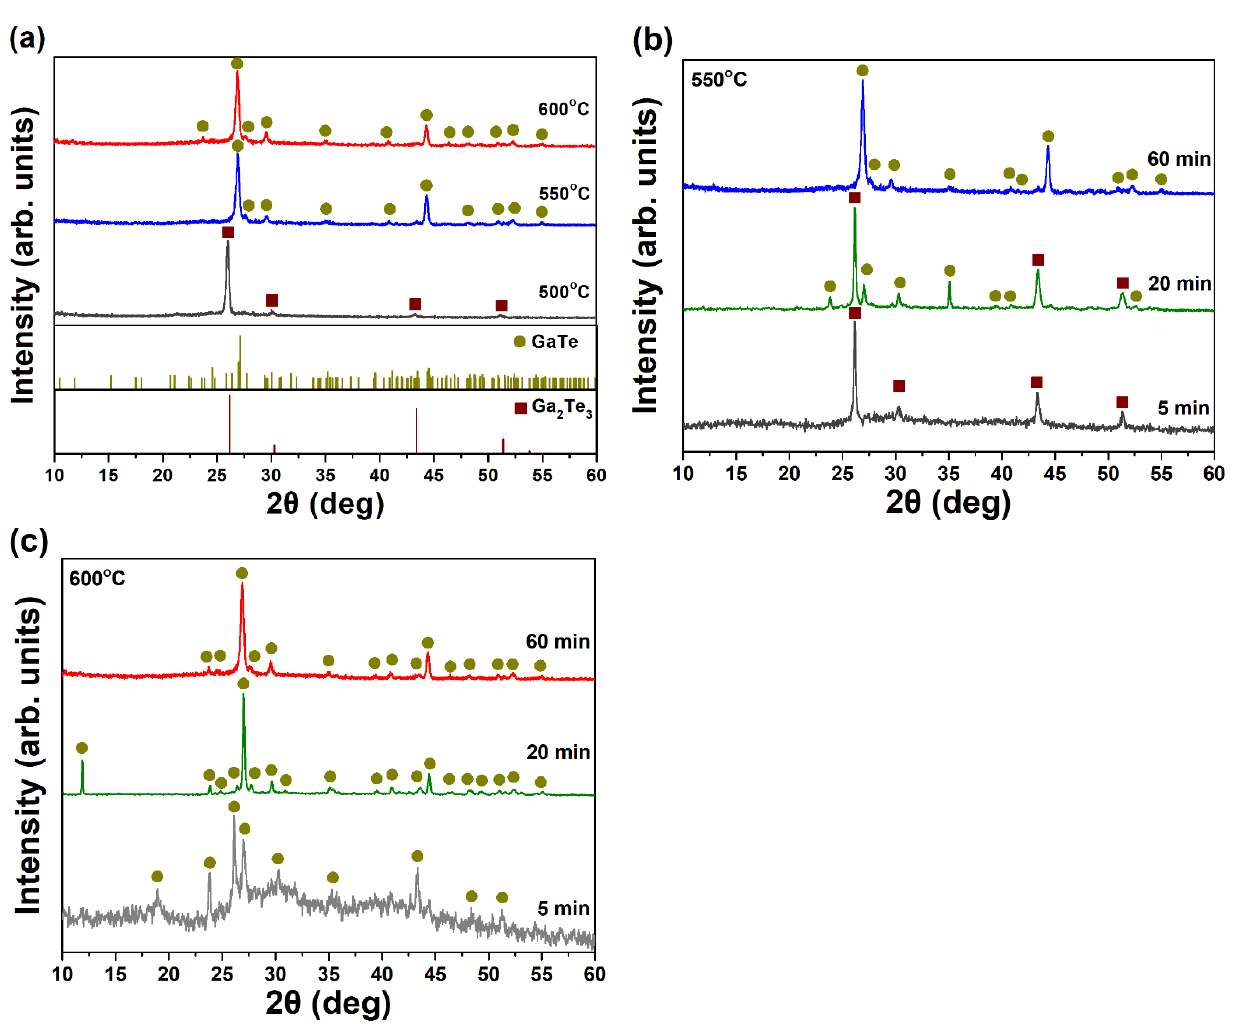
Figure 3. The XRD patterns of samples ( a ) grown at different growth temperatures (500, 550, and 600 °C) for 1 h, ( b ) grown at 550 °C with different growth time (5, 20, and 60 min), and ( c ) grown at 600 °C with different growth time (5, 20, and 60 min).